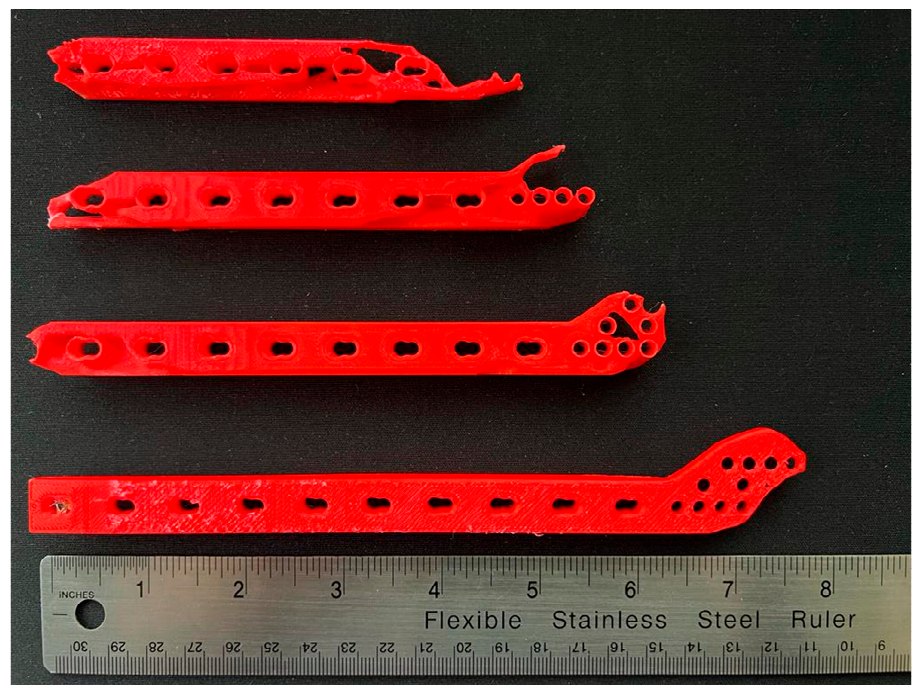
Figure 7. Initial and topology-optimized plates manufactured using fused filament fabrication technique.